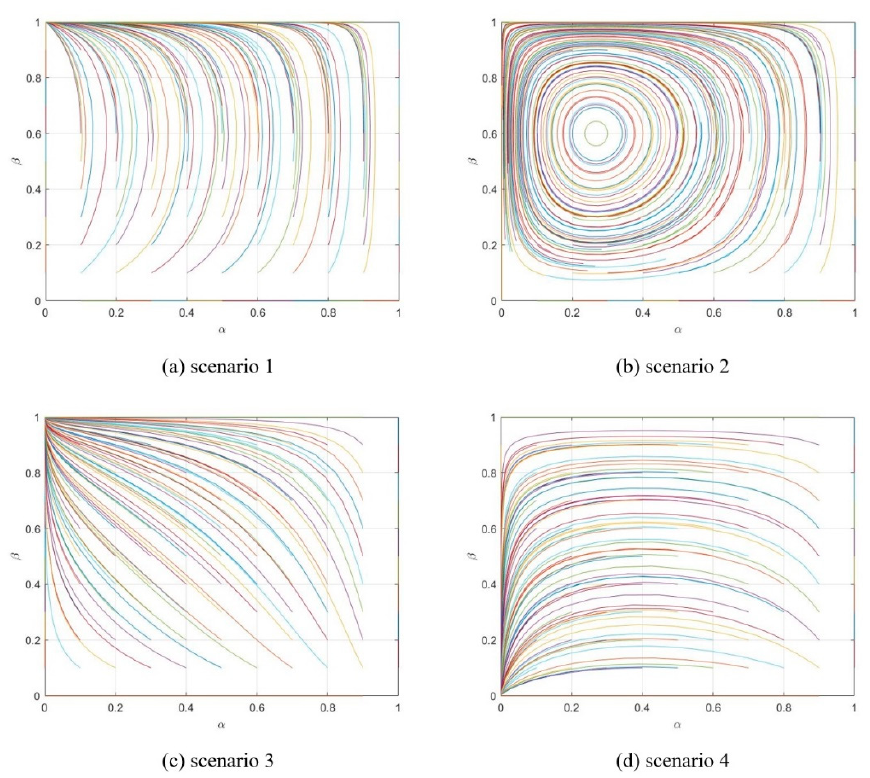
Figure 5. Simulation of scenarios 1 to 4 between local government and coal-related